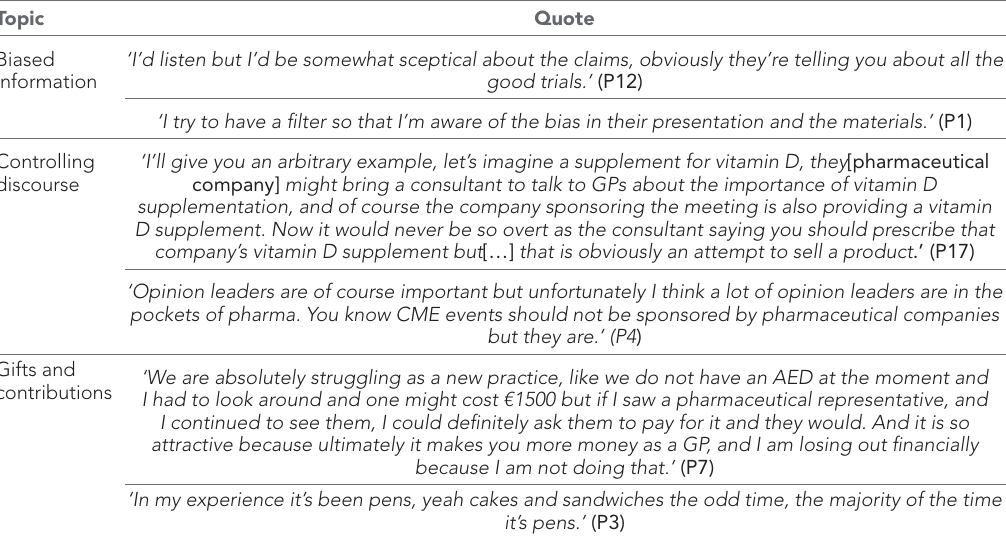
Table 3 Illustrative quotes of the methods of influence used by pharmaceutical representatives Topic Quote Biased